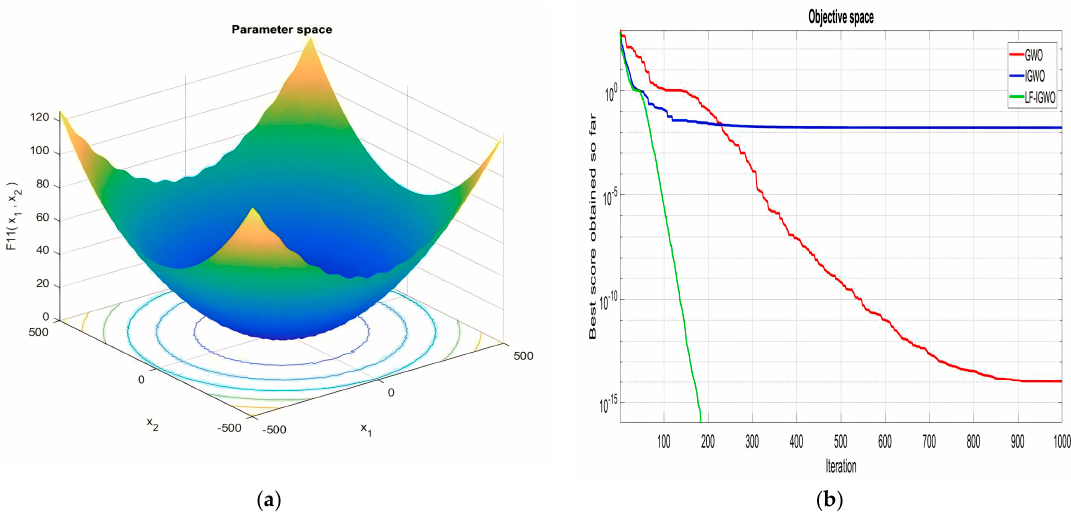
Figure 13. ( a ) Search space for multi model function F11 ( b ) Comparison of convergence curve for F11.